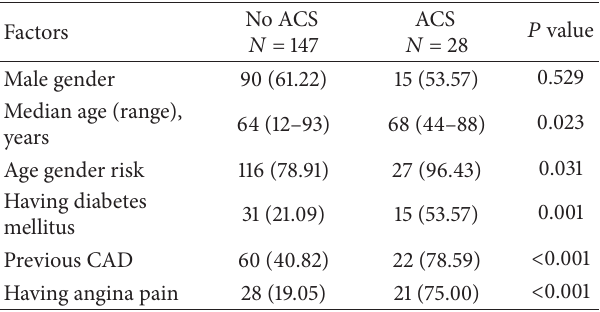
Table 1: Features of patients presenting with chest pain at the emer- gency department categorized by having acute coronary syndrome